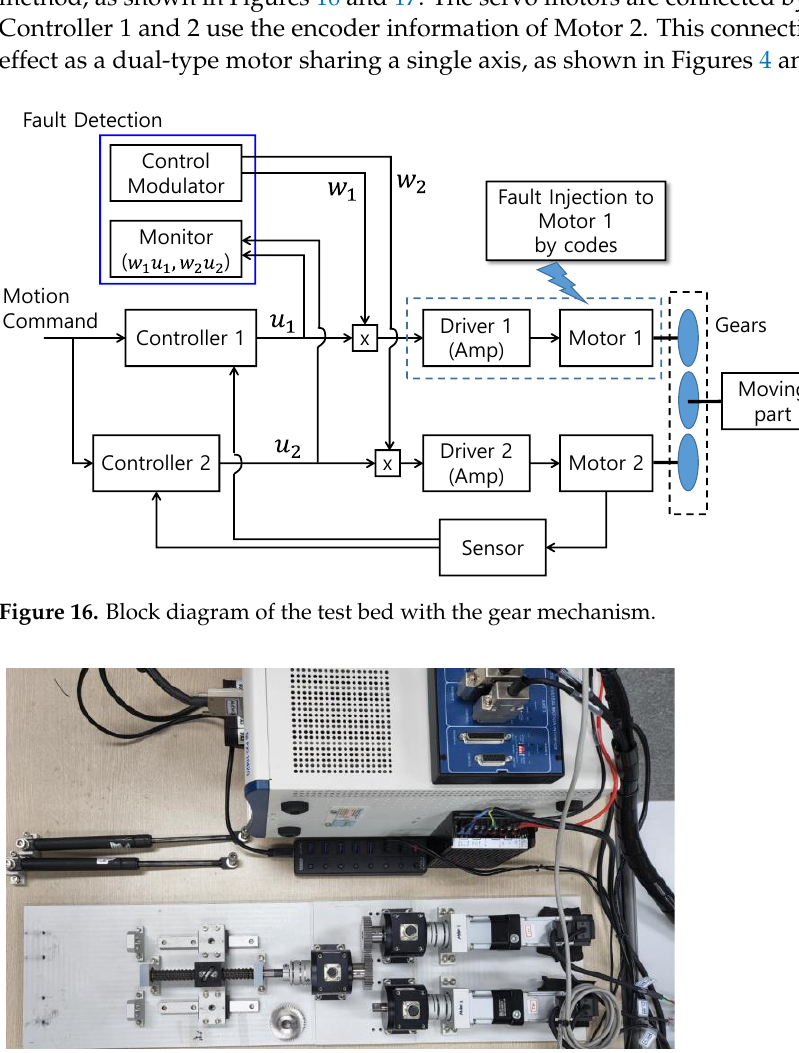
( d ) Figure 15. Commands and outputs: ( a ) Normal, ( b ) the zero output mode, ( c ) the fixed output mode, ( d ) the scaled-down mode.